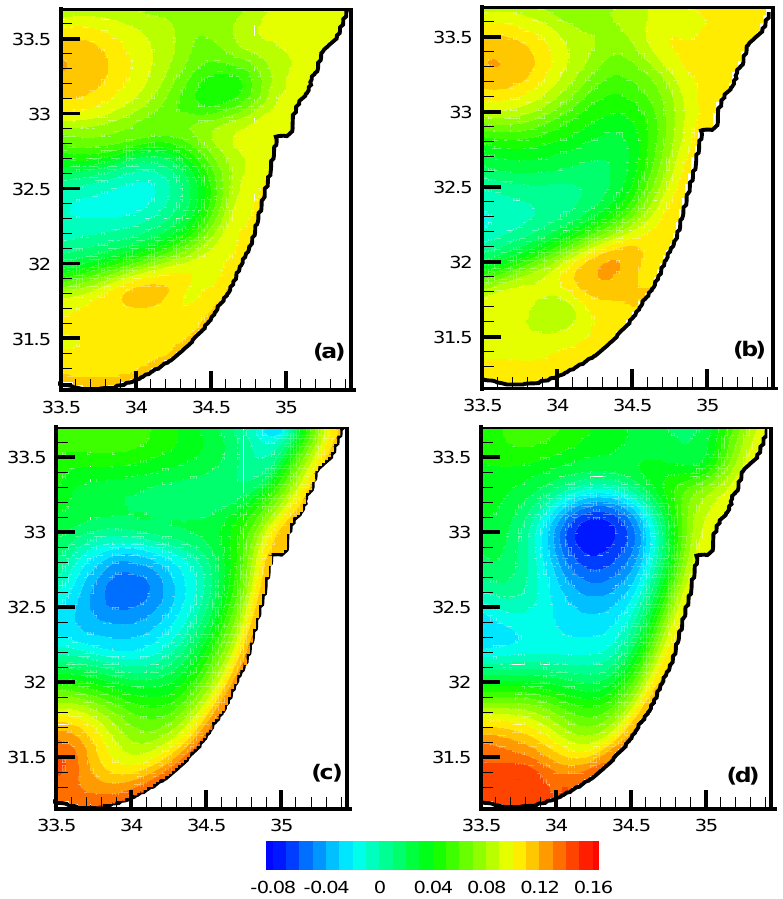
Fig. 13. Simulated free surface height: (a) 10-day average for 10–20 February of the third year, (b) 10-day average for 10–20 February from the interme- diate model, (c) 10-day average for 10– 20 August of the third year, and (d) 10- day average for 10–20 August from the intermediate